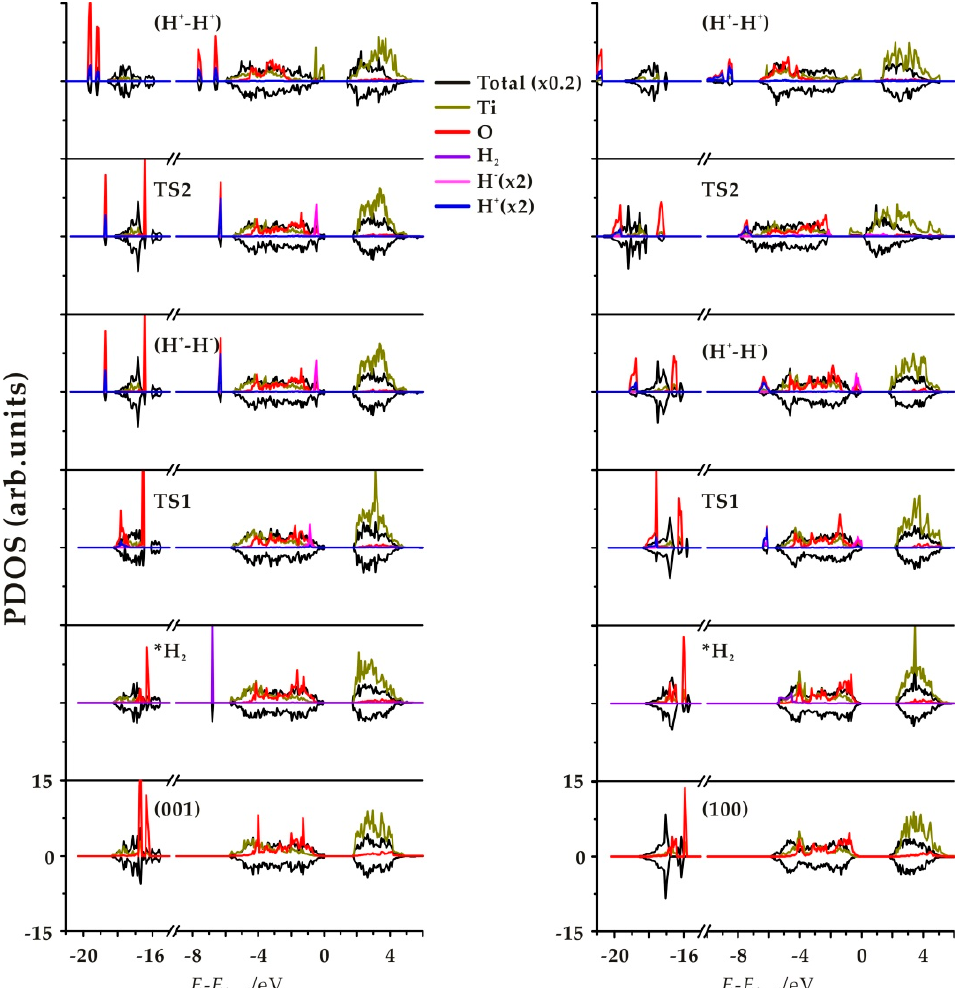
Figure 5. Total and projected densities of state (PDOS) of the TiO 2 slab, *H 2 , TS, *(H + , H − ), and *(H + -H + ) for the (001) ( left ) and (100) ( right ) surfaces. For the PDOS, only the Ti and O involved in the two processes are projected. Positive density of states (DOS) correspond to spin up and negative to spin down.